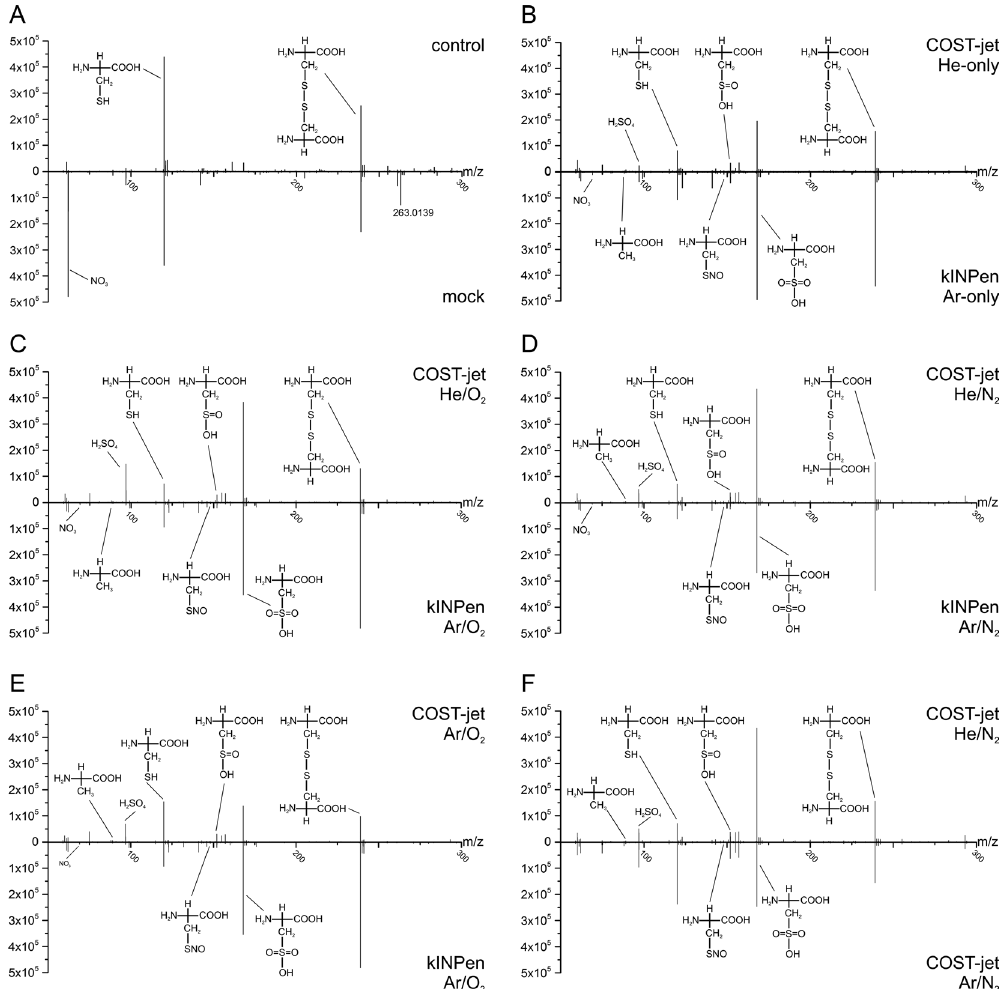
Figure 3. Mass spectrometry mirror plots of plasma-treated cysteine. Survey mass spectra of cysteine solutions, treated for 10 min with COST-jet or kINPen using varying working gas compositions. “Control” was treated with Ar-only gas (kINPen) for 10 min. “Mock” indicates the combined incubation of cysteine solution with 108 µ M H 2 O 2 , 200 µ M NO 2 , and 350 µ M NO 3 to simulate impact of long-lived plasma-generated